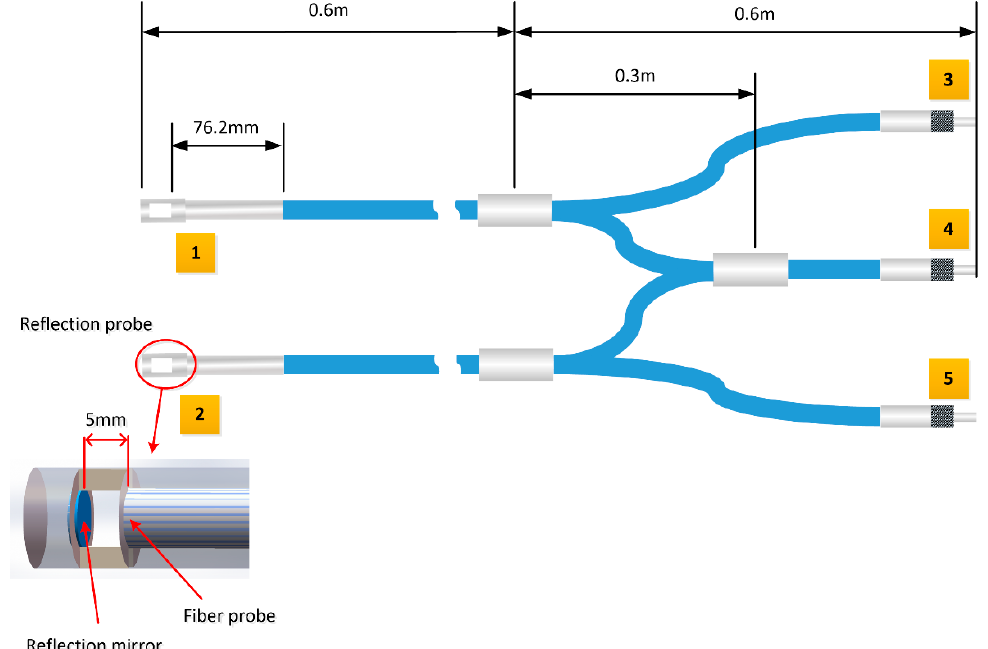
Figure 2. Structure of the UV fiber splitter.